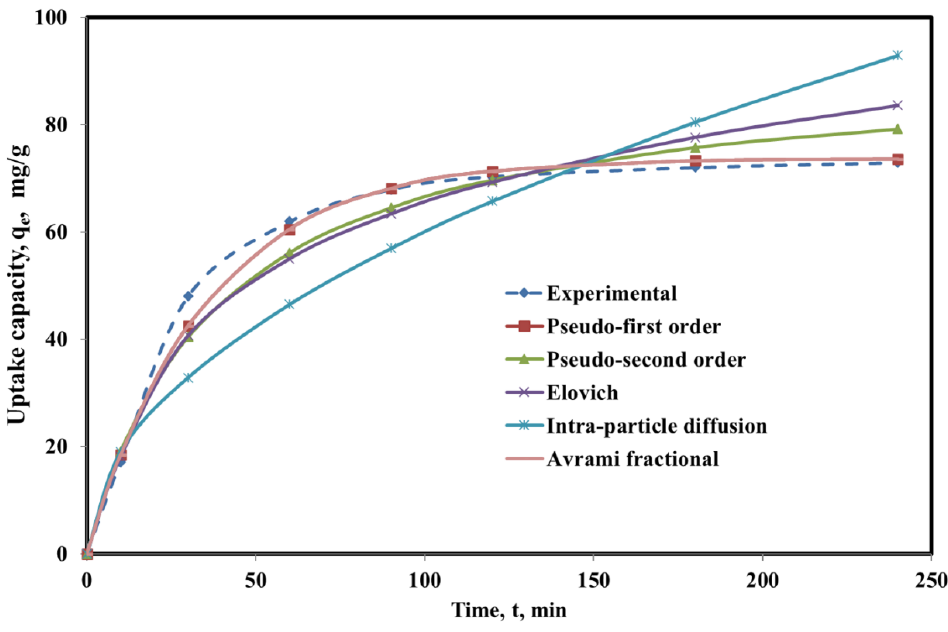
Figure 5. Plots for experimental data vs. predictions for non-linear kinetic models for SBAC-MgAlFe phenol uptake. Table 4. Parameters for different non-linear kinetic model fittings under the optimal